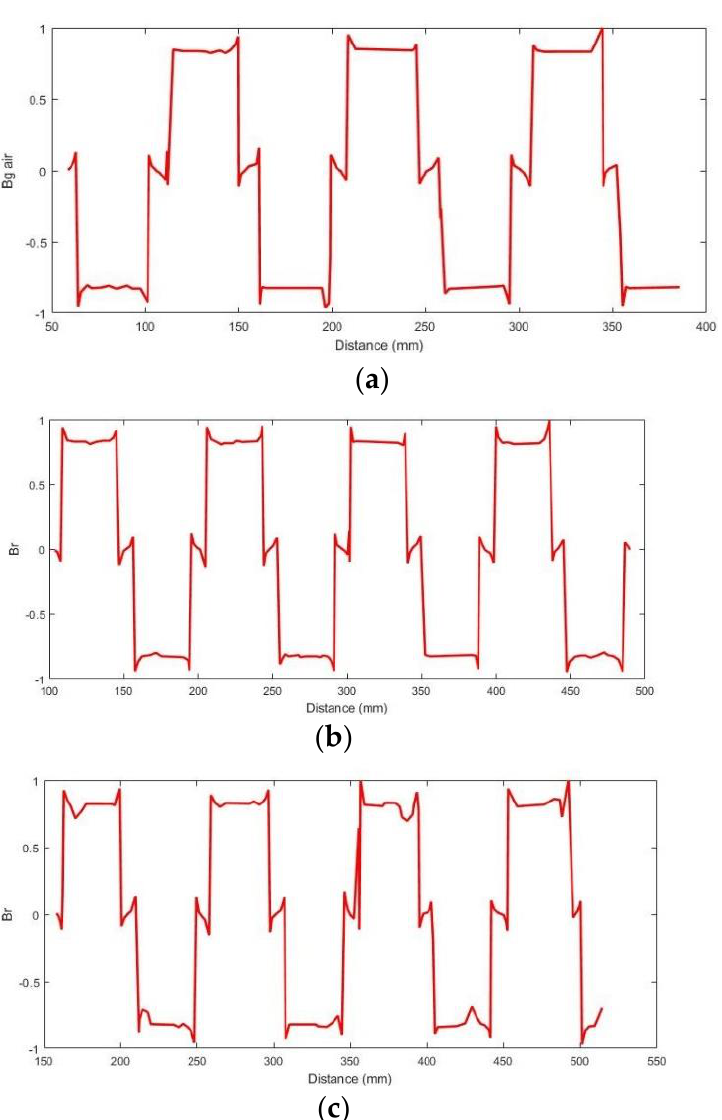
Figure 5. Flux density in the permanent magnet under the no-load condition: ( a ) slot opening = 2 mm, ( b ) slot opening = 4 mm, and ( c ) slot opening = 7 mm